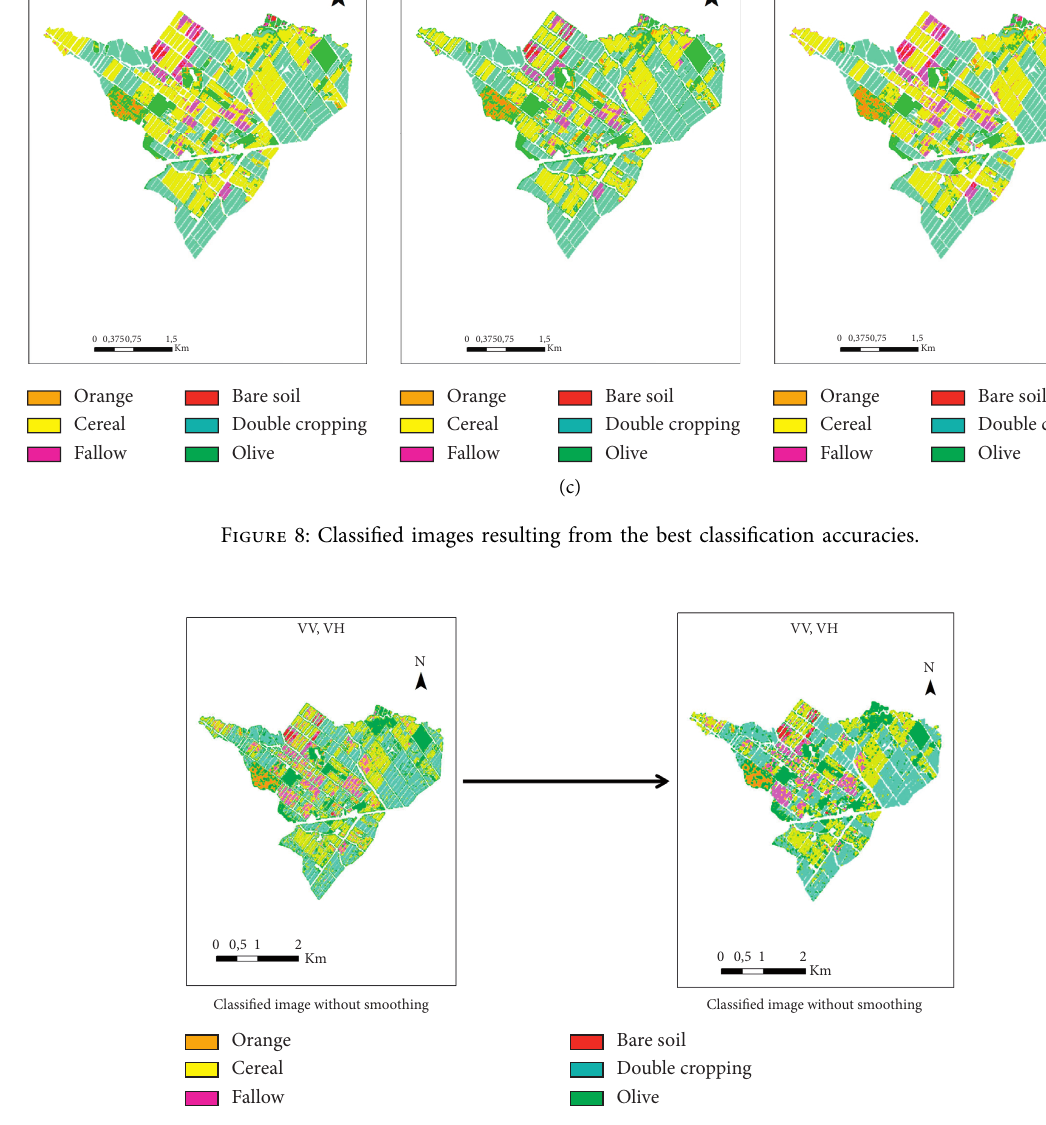
Figure 9: Improved quality of one of the classified images from radar products after